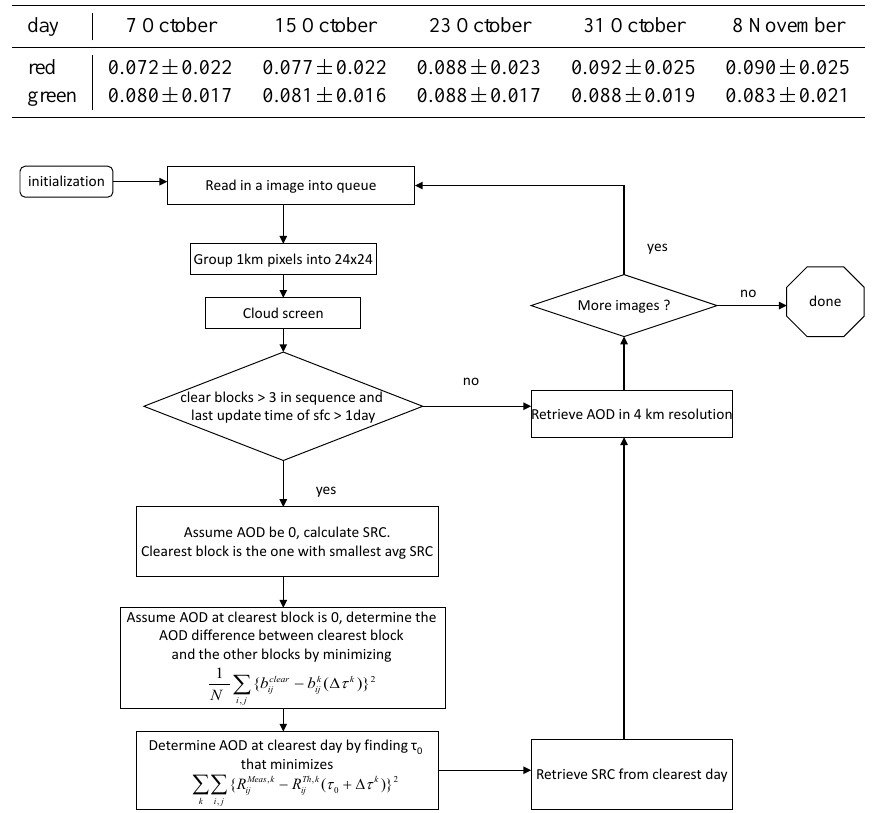
Fig. 2. Flowchart of the MAIAC algorithm for GOES AOD